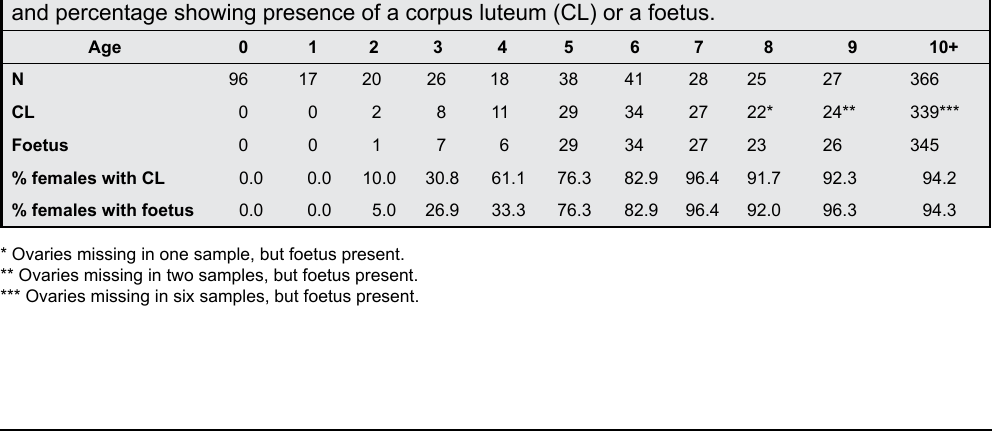
Table 3. Total number of female Icelandic grey seal ( Halichoerus grypus ) collected (N), number and percentage showing presence of a corpus luteum (CL) or a foetus.